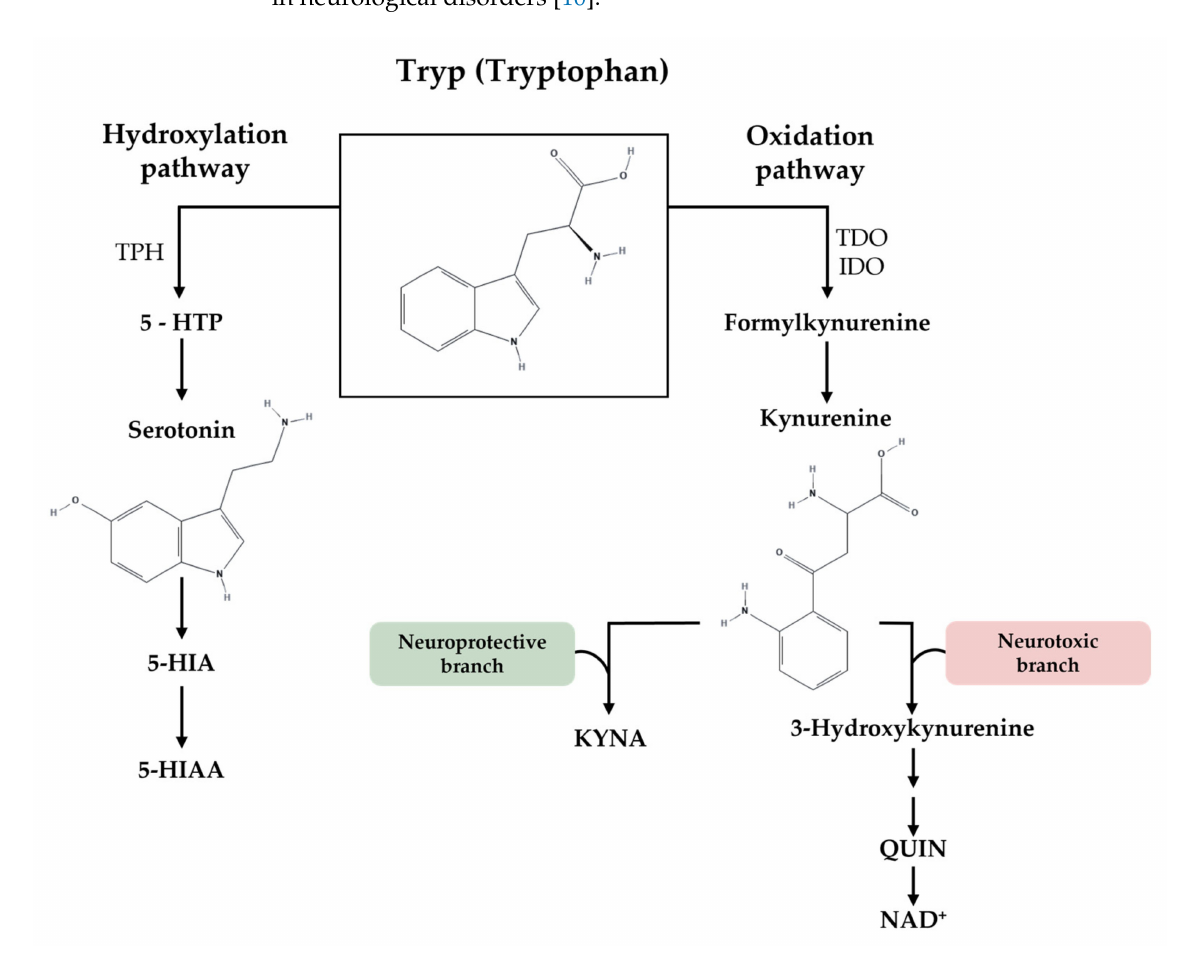
Figure 1. Tryptophan as a precursor of several biologically essential compounds. The metabolism of Tryp leads to the generation of several neuroactive compounds within the CNS. These include the neurotransmitter 5-HT and products of the kynurenine pathway. In the 5-HT pathway (left), Tryp is catalysed by TPH to produce 5-HTP, precursor of 5-HT, which is further metabolised to 5-HIA, followed by oxidation to 5-HIAA. In the kynurenine pathway (right), TDO and IDO catalyse the synthesis of kynurenine giving rise to critical neuroactive compounds such as QUIN and KYNA, often termed the “neurotoxic” and “neuroprotective” branches, respectively. 5-HIA—5-hydroxindole ac- etaldehyde; 5-HIAA—5-hydroxyindole acetic acid; 5-HT—serotonin; 5-HTP—5-hydroxytryptophan;